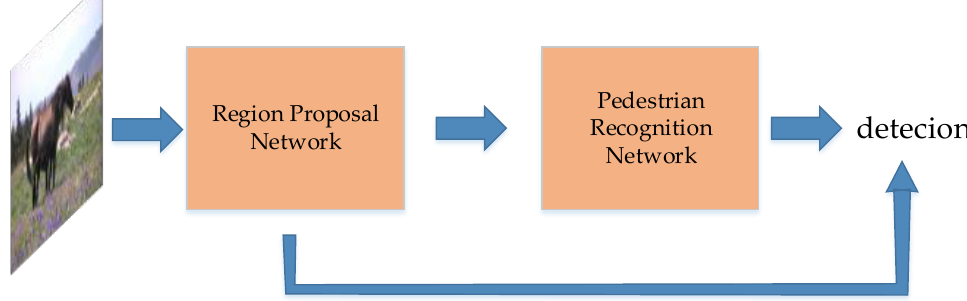
Figure 30. The pipeline of PEN, the final detection is concatenated by Pedestrian Recognition Network and the previous Region Proposal Network.